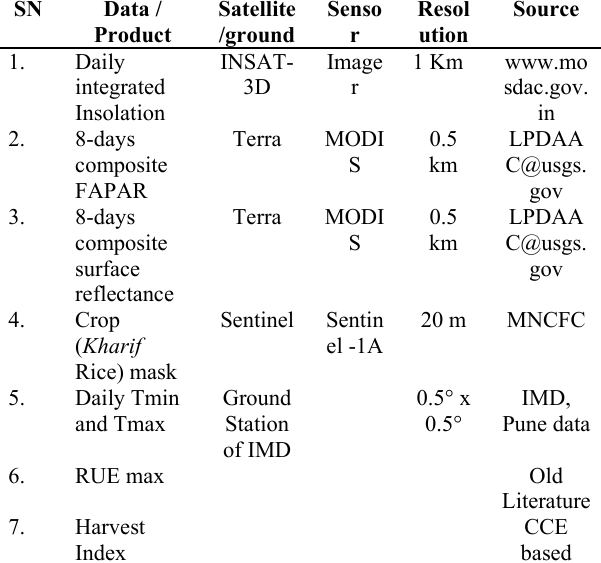
Table 1: Details of satellite data products used in this study are as